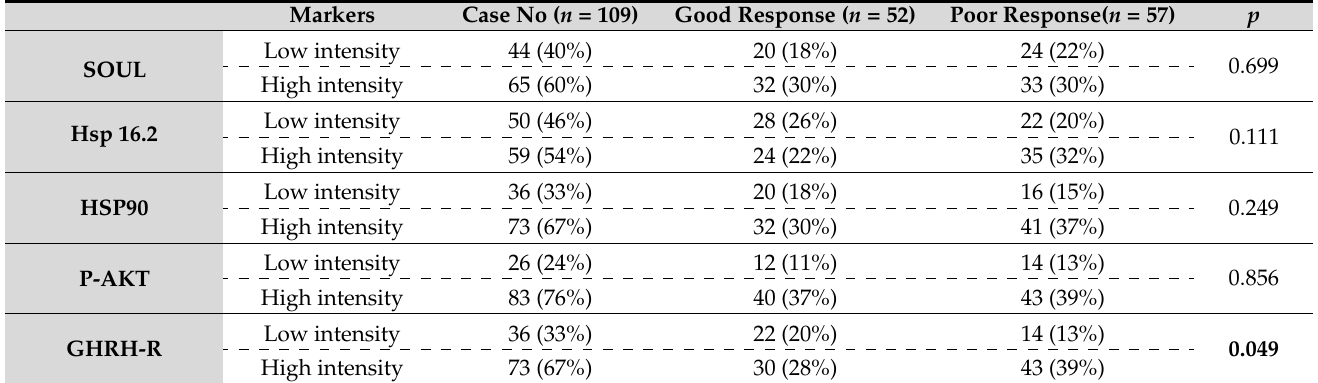
Table 3. Relationship between protein expression and the histopathological response to NRCT (n = 109).